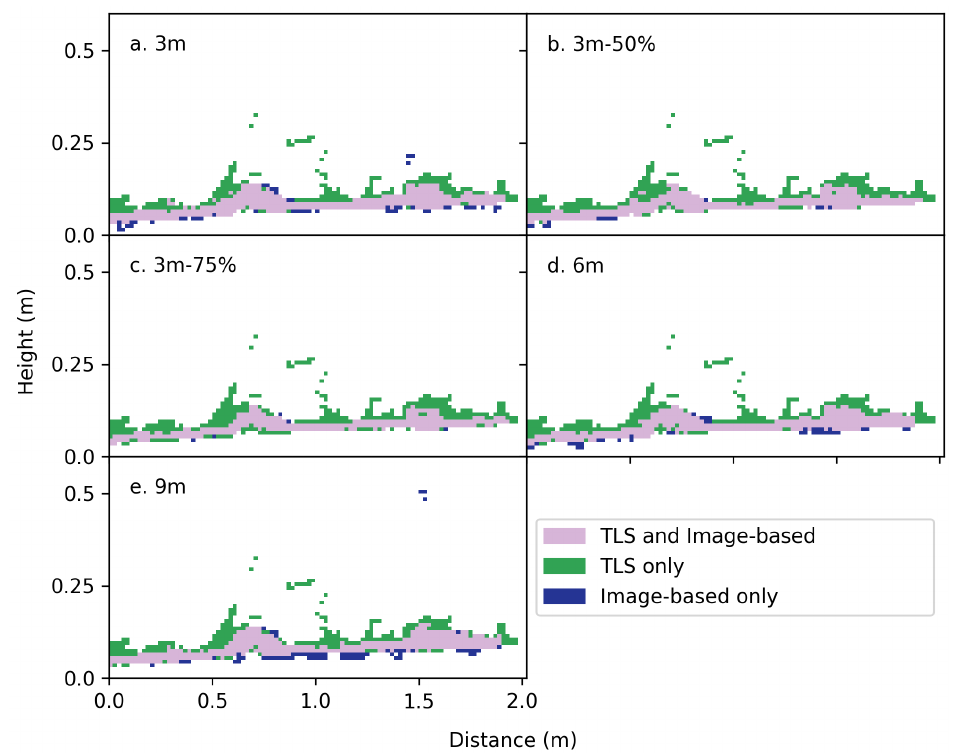
Figure 8. Differences in one horizontal row (2cm wide) between the TLS and image-based voxel representations of the point clouds generated for Plot 4.